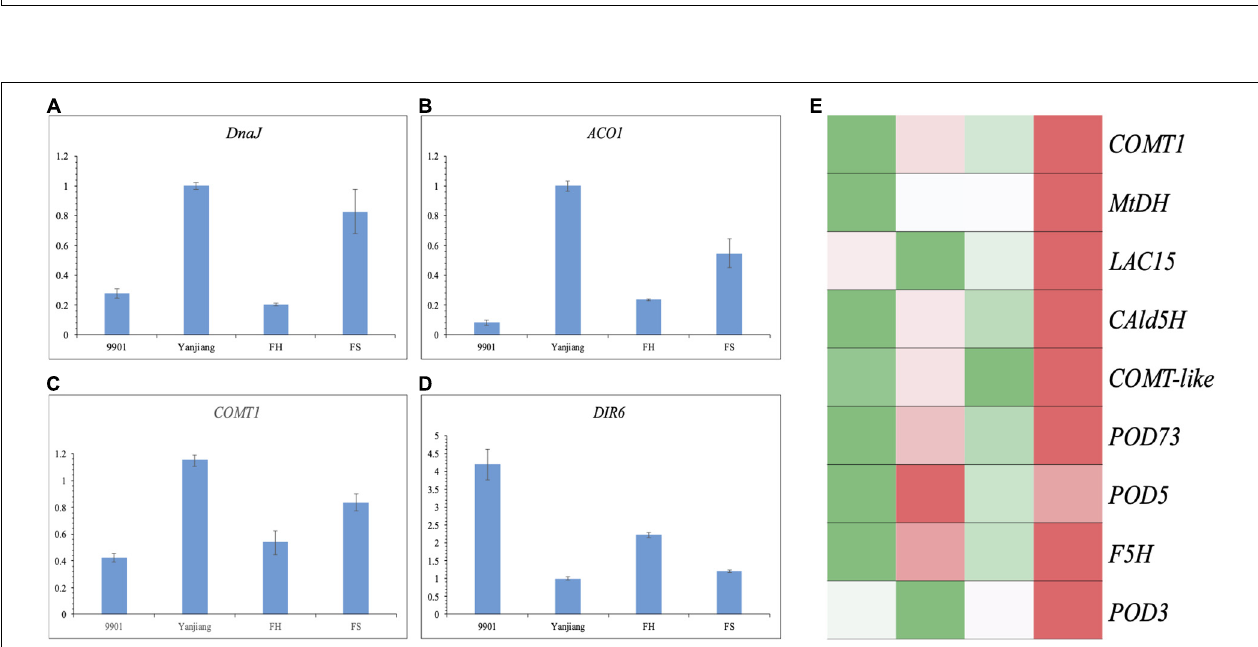
FIGURE 5 | The expression trend of candidate genes and lignin biosynthesis related genes in the two parents and two progenies. (A–D) qRT–PCR analysis of the transcript levels of candidate genes in the two parents and two progenies. The Y-axis represents the relative expression level, and the X-axis represents different cultivars. The error bars denote the standard error (SE). (E) Heatmap analysis of lignin biosynthesis related genes in the two parents and two progenies.